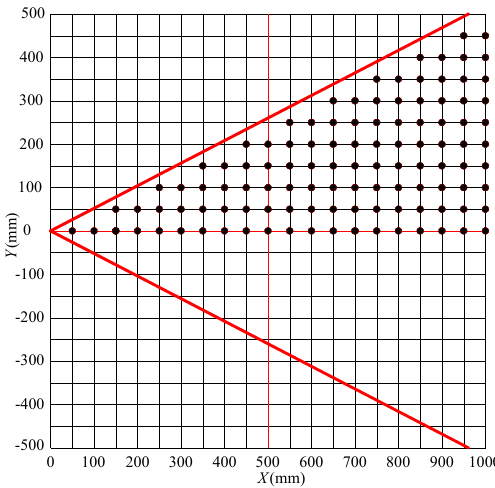
Figure 5. Measuring point layout.